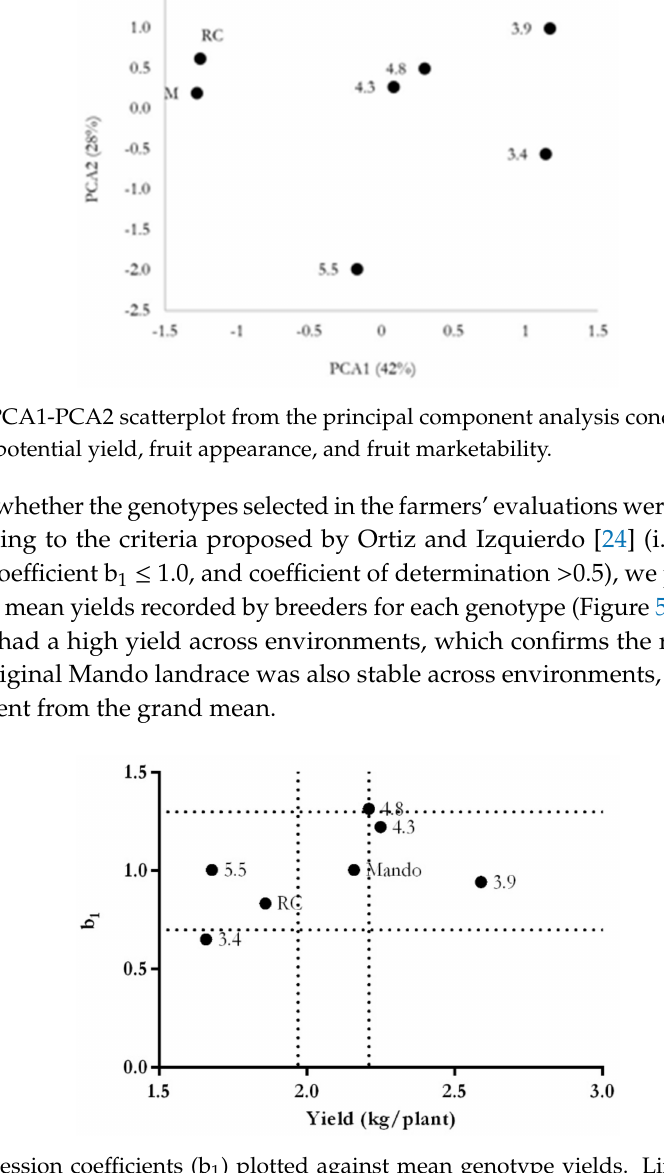
Figure 5. Regression coe ffi cients (b 1 ) plotted against mean genotype yields. Lines parallel to the X-axis separate values statistically di ff erent from 1.0, and lines parallel to the Y-axis separate values significantly higher or lower than the grand mean. Genotypes located in the area where yield is greater than the grand mean and b 1 ≤ 1.0 are regarded as stable, high-yielding